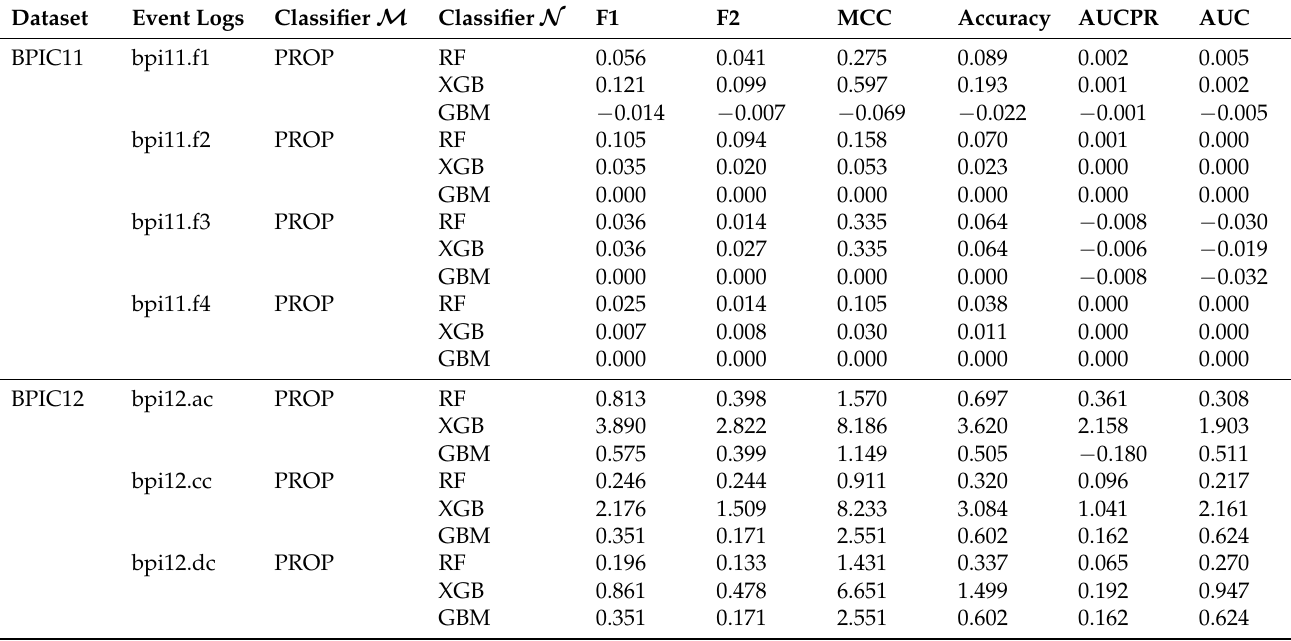
Figure 3. ( a , b ) Correlation plot denoting clustered solution spaces. The color represents the perfor- mance score (e.g., low, yellow; high, red) of classifier, ranging from 0.4 to 1. For each performance metric, the datasets are roughly grouped based on the classification algorithms. Table 2. Percentage improvement that the proposed model offers over base